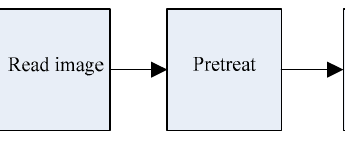
Fig. 2 Processes of improvement algorithm.